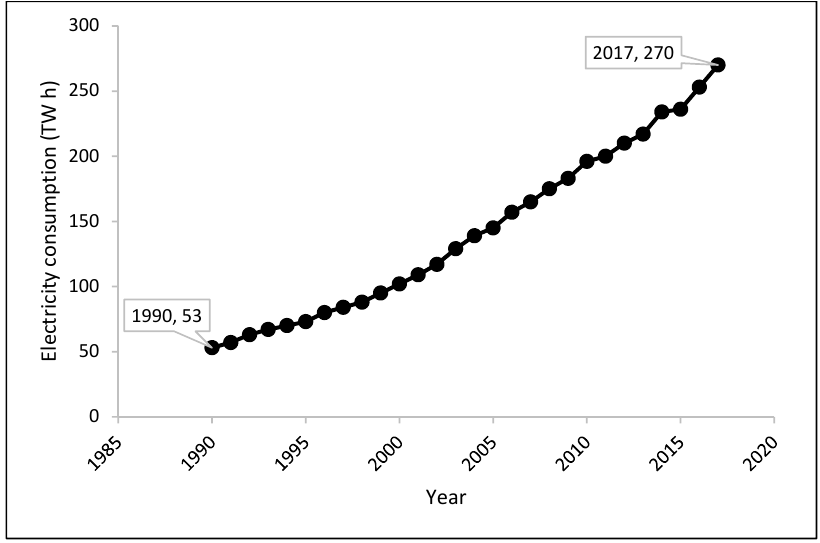
Figure 9. Specific energy consumption in terms of electricity based in Iran from 1999 to 2017, modified from [172]. Terawatt-hour (TW h), a measure of electrical energy, equals to 10 12 watt-hours. During the process of energy commercialization, energy consumption in households changed dramatically. In Iran, the share of electricity increased significantly from 53 to 270 TW h between 1999 and 2017, respectively (Figure 9). In this period, annual per capita energy consumption based on electricity increased to 0.95 terawatt-hours (TW h). The transition of fuel composition could be partly explained by households’ intensifying share of direct energy use among all household purchases. In urban Iran, the share of delivered energy used for cooking and heating decreased 12%, while the share of energy used for lighting, cooling, and electric appliances increased 12% [173]. After the revolution in Iran in 1979, the primary fuel for cooking and hot water has gradually switched from coal to LPG in urban Iran. Many studies indicate that household direct energy consumption also varies tremendously across Iran [18,36,173]. Per household CO 2 emissions in central Iran are 69% higher than the national average level. However, in the cities of Western Iran, per capita, household CO 2 emission is 17% lower than the national average. Rural households in the northeast, south, and southwest Iran tend to be more likely to use biomass than are other regions. Although Iran had already developed a legal foundation in support of energy efficiency for residential buildings and home appliances [60], its efficiency standards were relatively low compared to those applied in western developed countries. Perhaps more critically, Iran’s monitoring and enforcement of energy efficiency standards and labels were relatively weak. Few policies directly targeted consumers’ energy consumption behaviors. Still, in the summer of 2007, Iran’s state council required all government agencies to set their thermostats no lower than 26 degrees Celsius in public buildings. Nonetheless, this environmental edict was largely ignored by provinces and cities outside of Tehran and even some local officials within Tehran [60]. Household-targeted policies about rational energy consumption remain a missing component in Iran. Thus, a study of households’ energy consumption behavior is undoubtedly significant to inform energy policy. 8. Conclusions An attempt has been made in this study to review relevant literatures on household energy consumption and related CO 2 emissions in Iran with the view to establishing the gap that exists. The nexus between household fuel choice and consumption has been a subject of academic scrutiny by researchers over the years. Most studies of household energy consumption in Iran focus on direct energy consumption factors such as the transition of the fuel mix and changes in end-use structures.